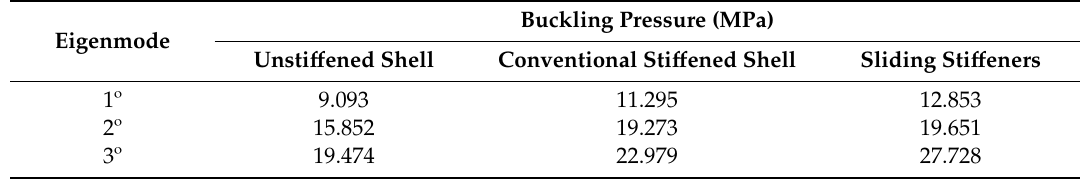
Table 4. Buckling pressures for di ff erent eigenmodes.